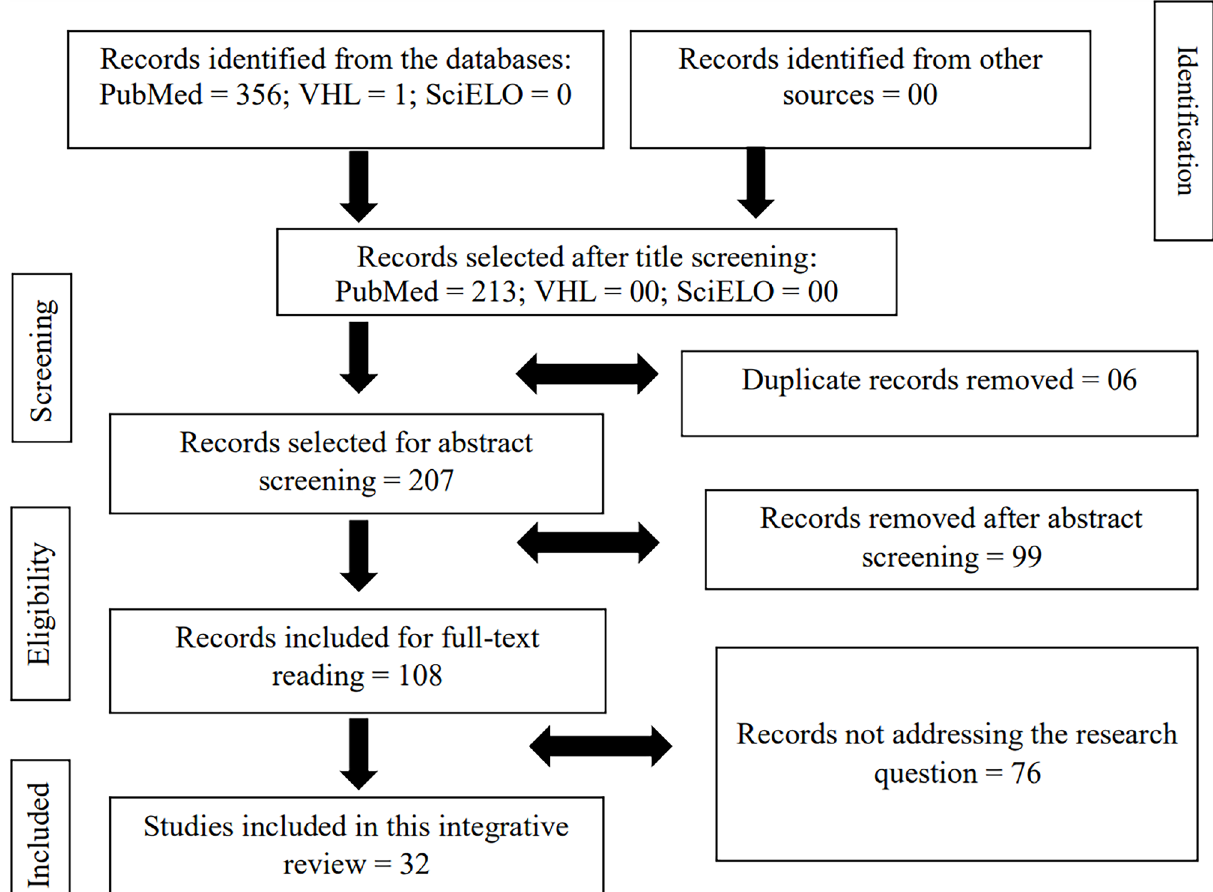
Figure 1. Research